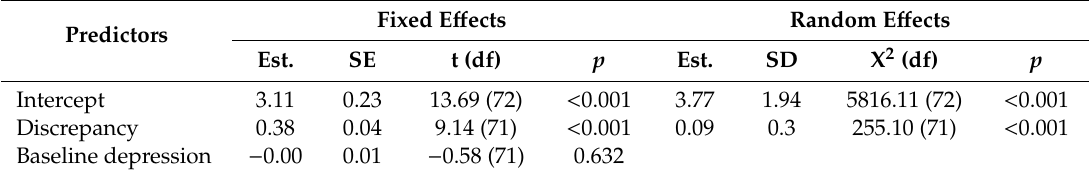
Table A4. Parameter estimates for multilevel model A.4.